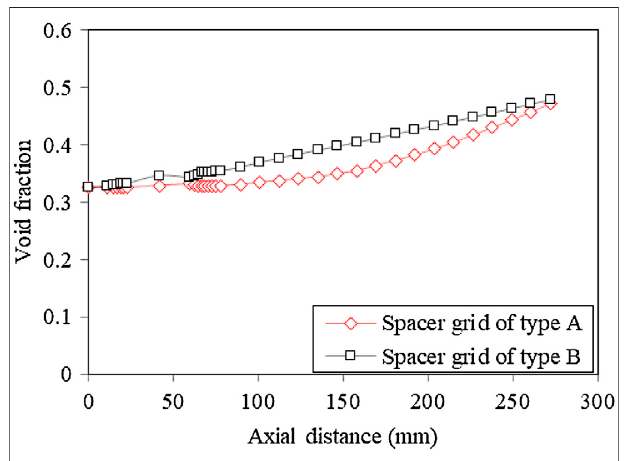
FIGURE 12 | Average void fraction of cross sections along axial